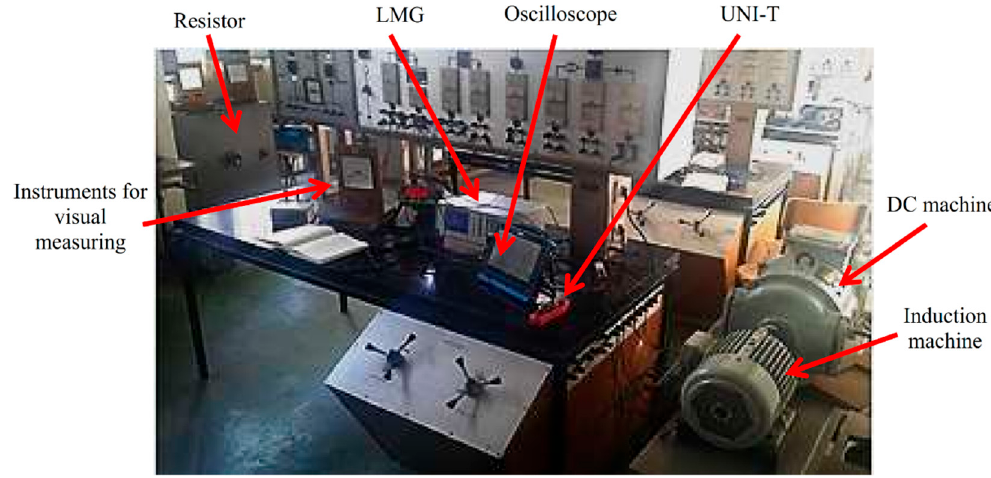
Figure 10. Experimental setup. Table 24. Estimated IM parameters: Experimental